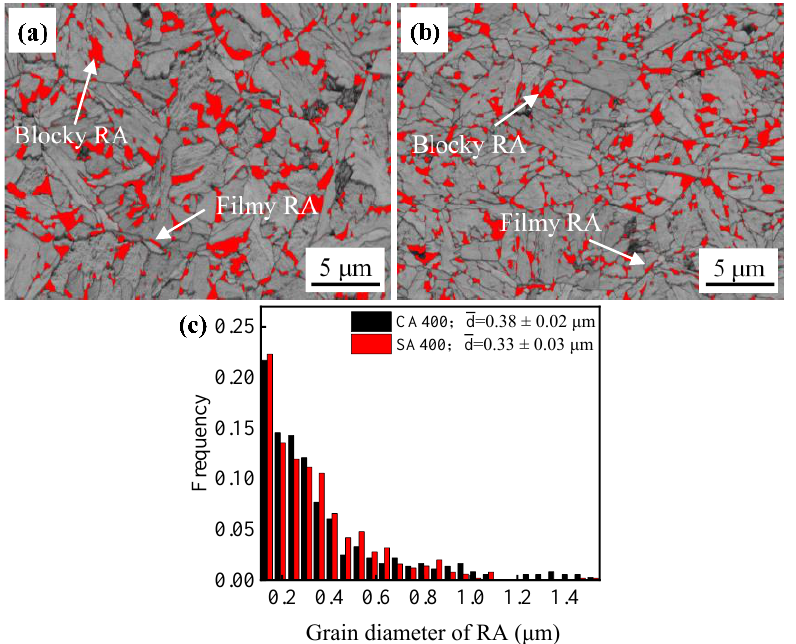
Figure 5. Band contrast (BC) maps of sample CA400 ( a ) and SA400 ( b ); ( c ) the grain diameter distribution of RA.